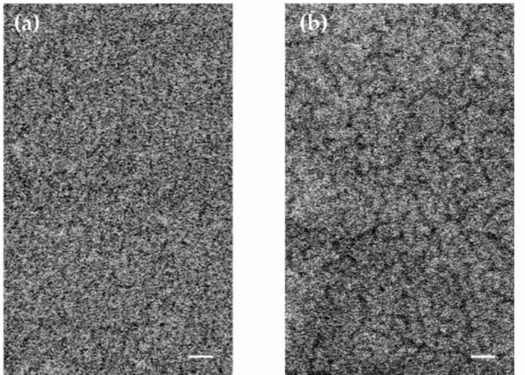
Figure 5. SEM micrographs of the surface of the metallized PET substrate before ( a ) and after 1000 ( b ) bending deformations. The bar is 100 nm.